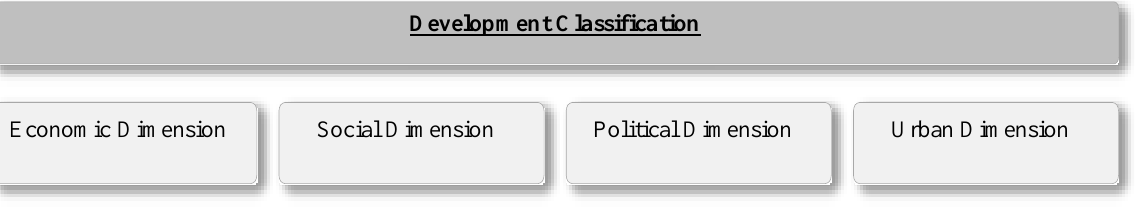
Figure 1: Shows the classification of development in accordance with the main dimensions and the main types. Source: (Heba Saif al-Islam,